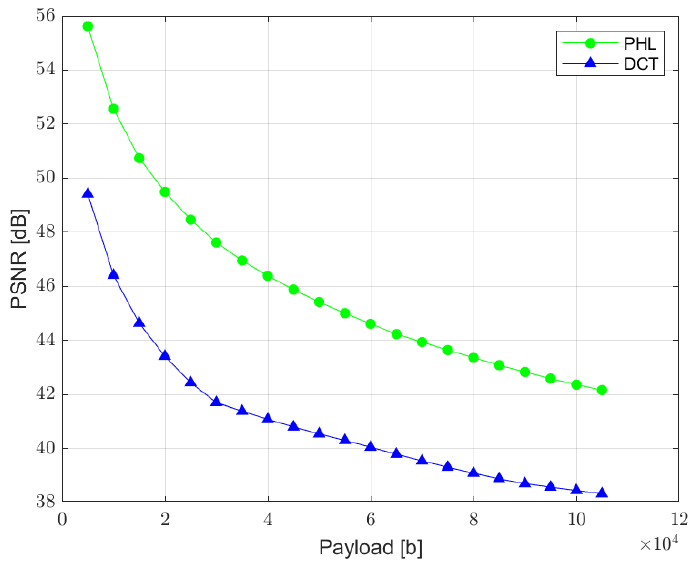
Figure 10. Relation between PSNR ratio and the watermark capacity (PHL vs.